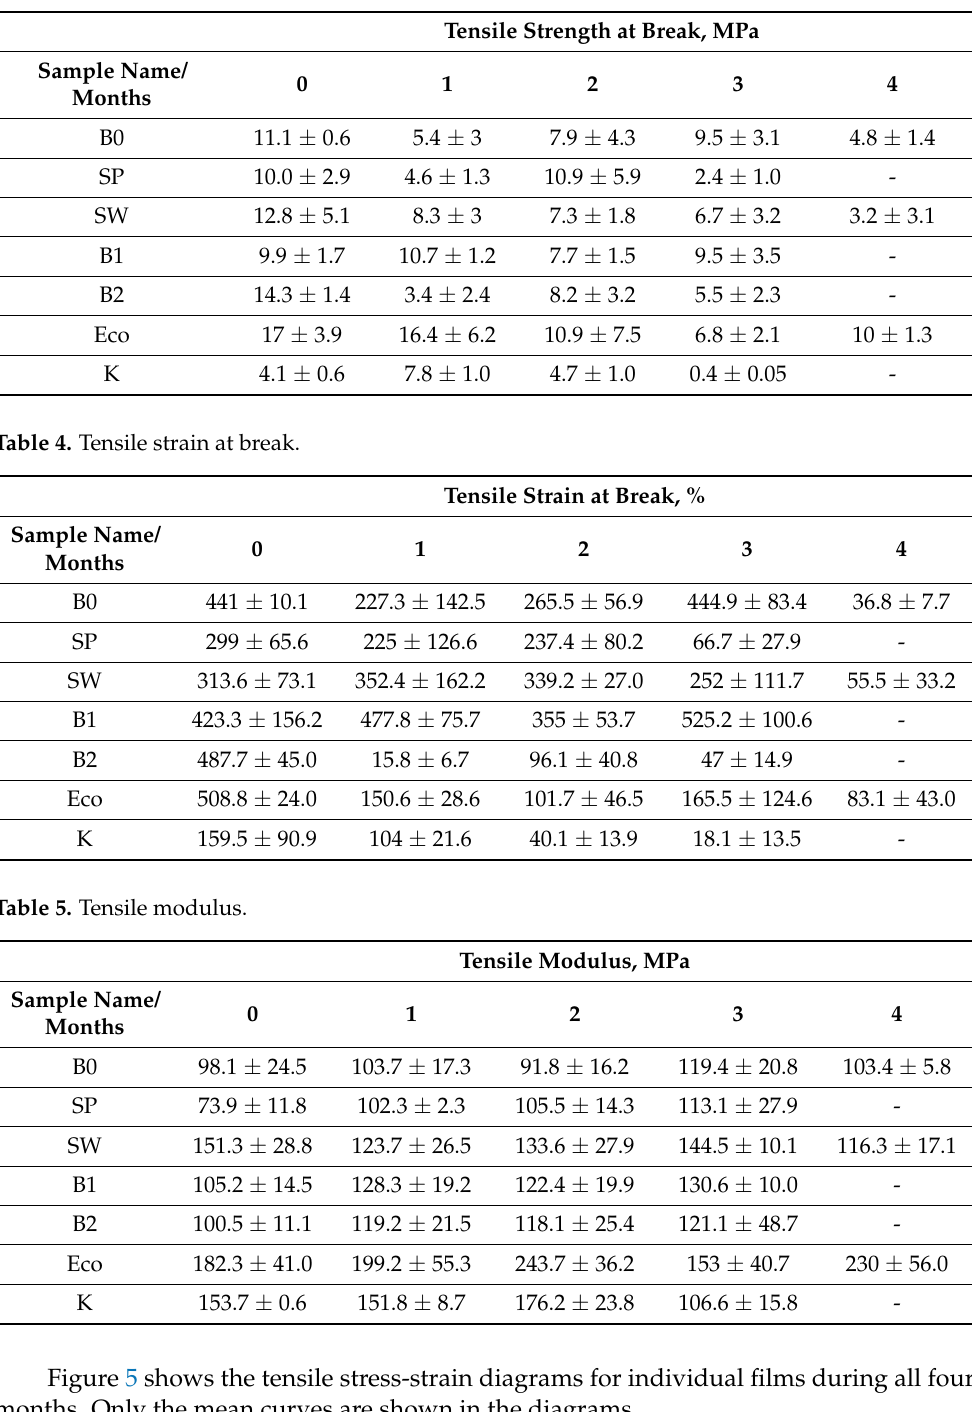
Table 3. Tensile strength at break.